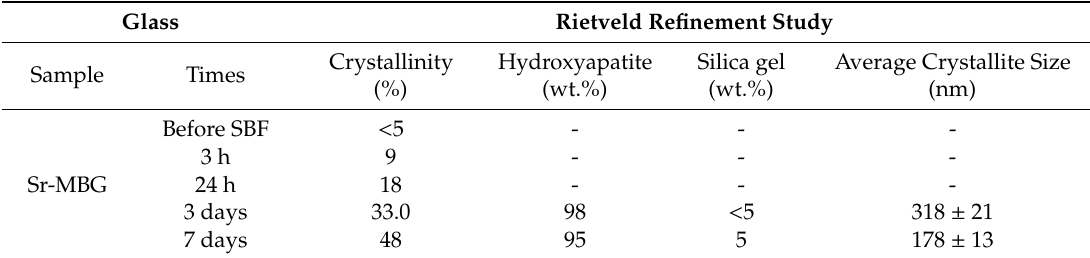
Table 3. Summary of the results of Rietveld refinement study for Sr-MBG.